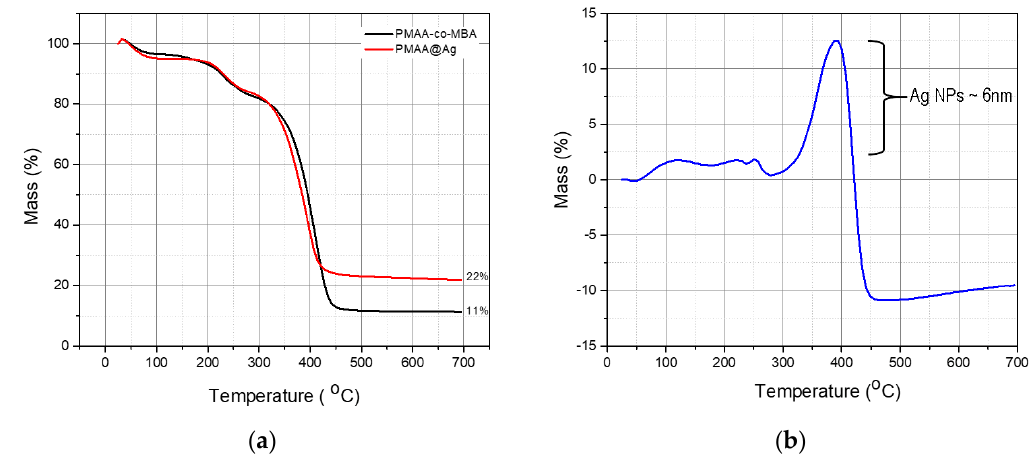
Figure 7. ( a ) TGA curves for the PMAA-co-MBA and the PMAA@Ag sample; ( b ) mass percentage subtraction [(PMAA-co-MBA%—PMAA@Ag%] of the curves presented in Figure 7a vs. temperature.